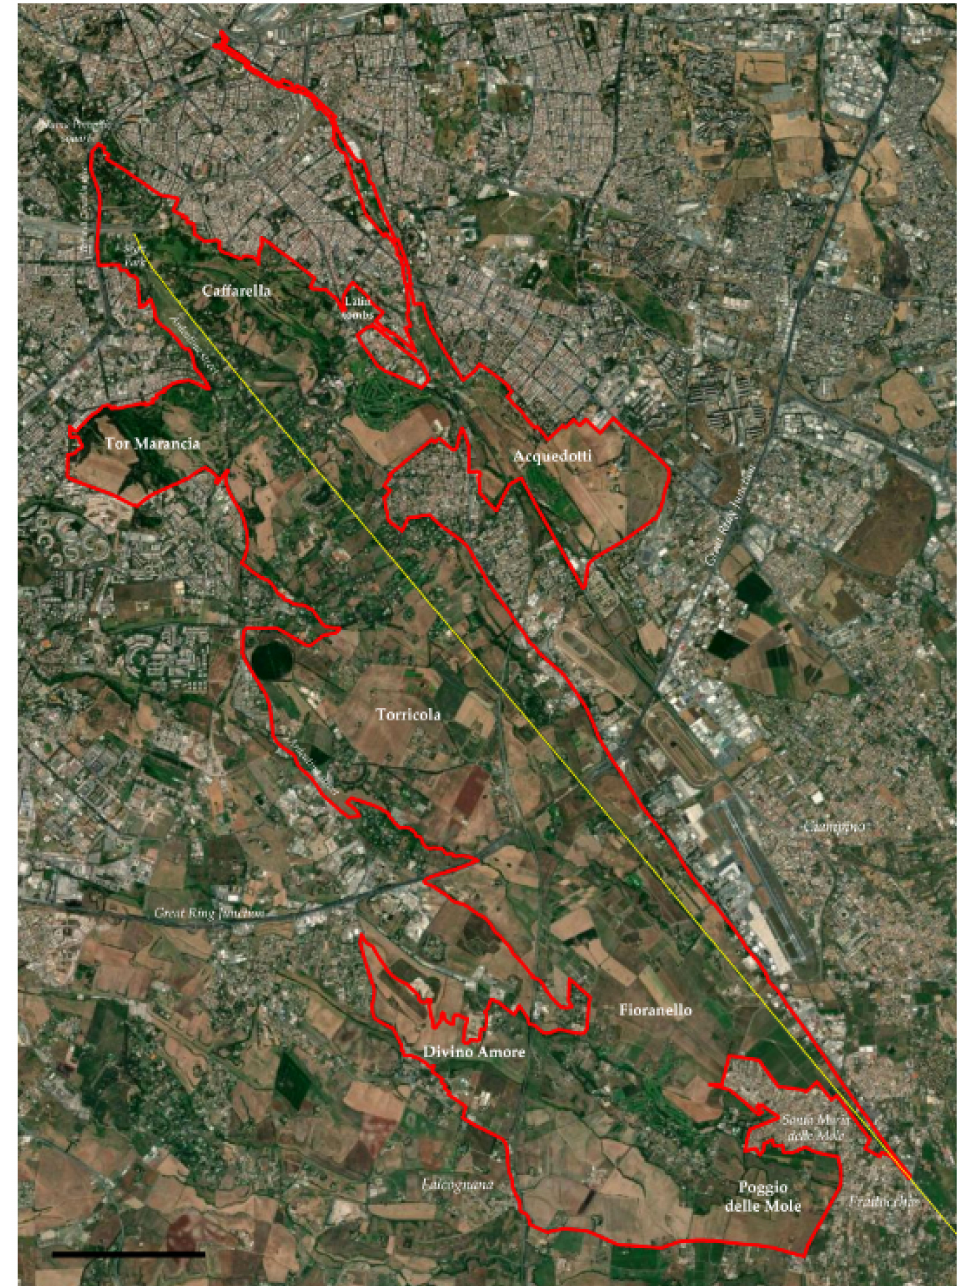
Figure 1. Map of Appia Antica Regional Park (boundary in red line) with main localities and streets; yellow line: Appia Antica street. Scale bar = 2